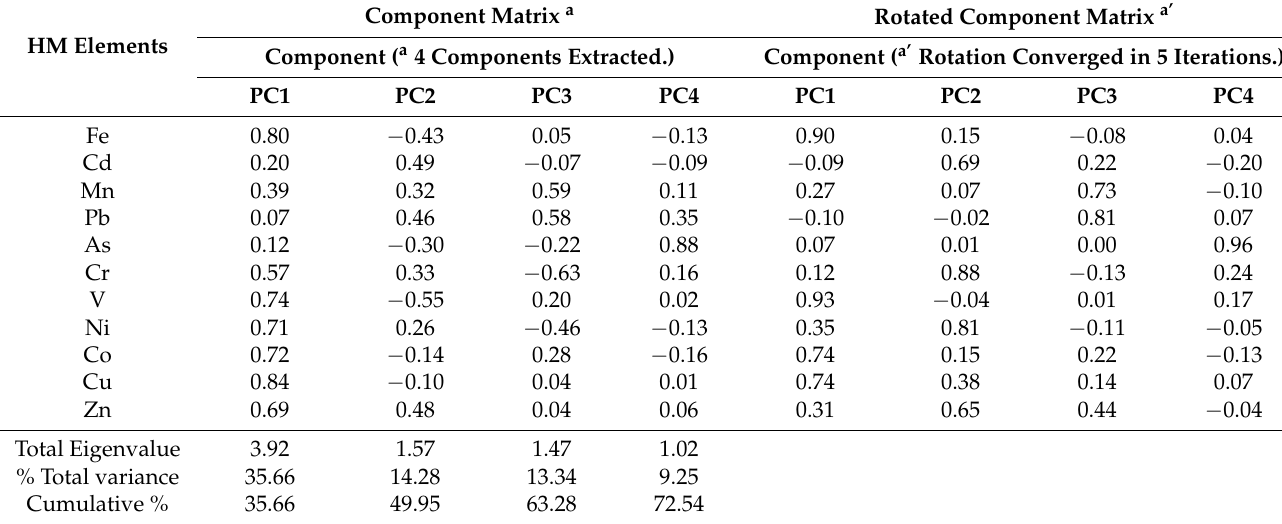
The first PC explained 35.66% of the total variance and was dominated by Cu, Fe, V, Co, Ni, Zn and Cr elements with proportions of 0.84, 0.80, 0.74, 0.72, 0.71, 0.69, and 0.57, respectively (Table 4), for the non-rotated matrix. The second PC explained 14.28% of the total variance and was dominated by Cr, Ni, Cd, and Zn with values of 0.88, 0.81, 0.69 and 0.65, respectively. The third PC explained about 13.34% of the total variance. The rotated PCA was dominated by Pb and Mn with values of 0.81 and 0.73, respectively, and with negative loadings for Fe, Cr, and Ni. The fourth principal component explained 9.25% of the total variance and was dominated by As with a proportion of 0.96 and negative loadings for Mn, Ni, Co, and Zn. Likewise, the cluster analysis result shows that V, Fe, Co, and Cu were grouped into a similar cluster (Figure 3).